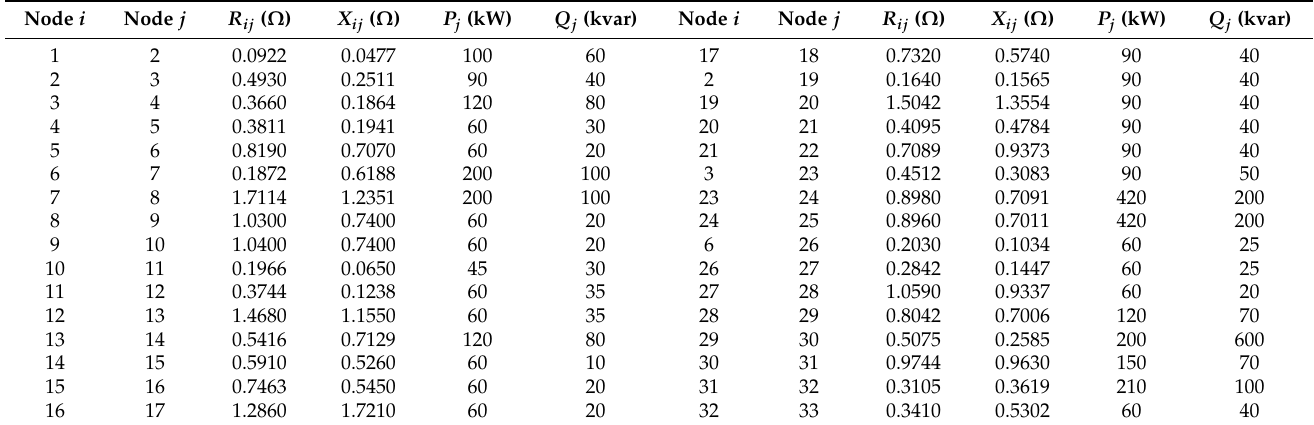
Figure 4. Schematic interconnection in the 33-node test system. Table 5. Parameters of the 33-node system.